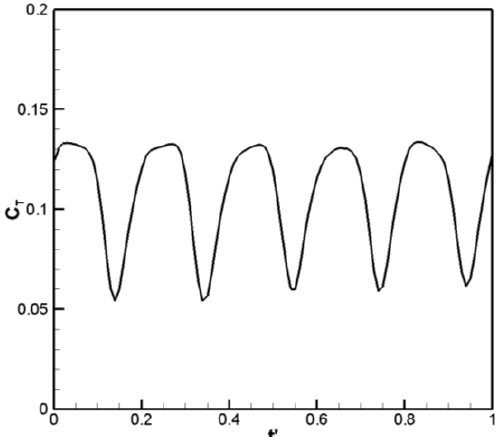
Figure 6. Aerodynamic torque on the rotor for one rotor revolution with ambient wind velocity of 10 m/s and prescribed angular velocity of 2 π rad/s. A non-dimensional time relative to rotor rotation cycle t’ = t / T is used in the plot.